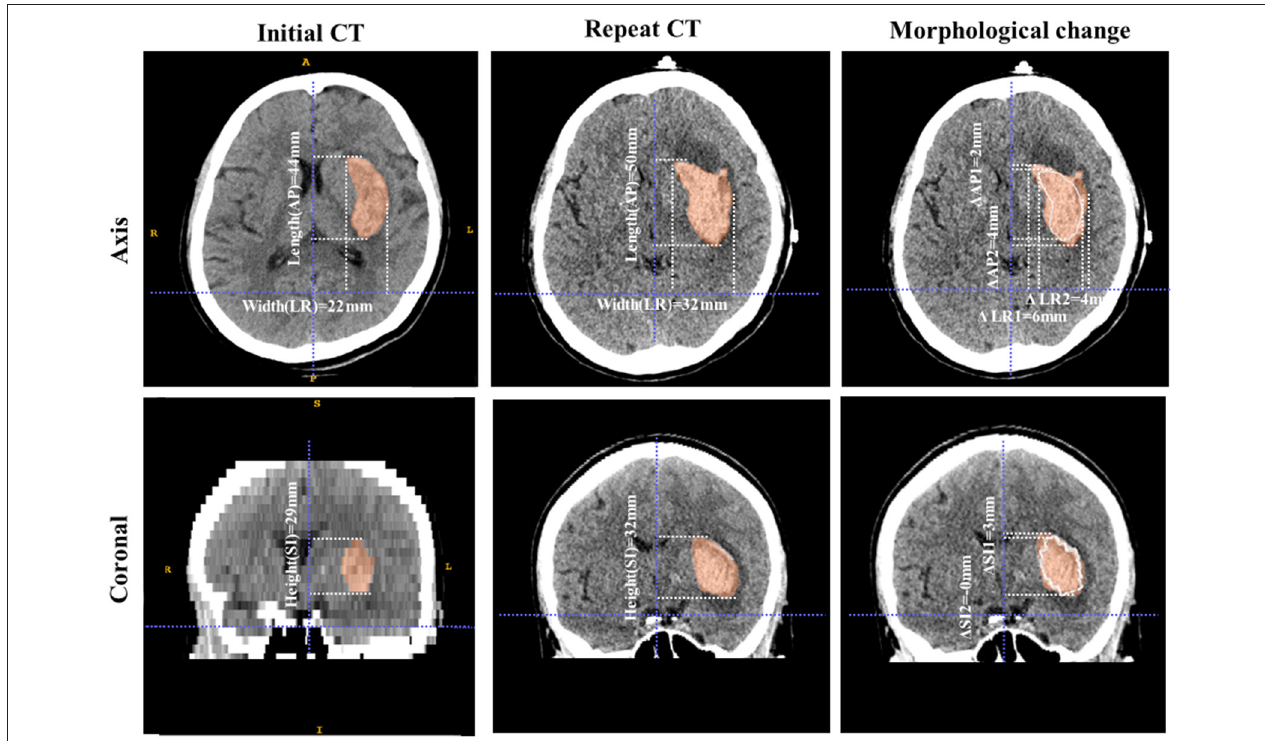
FIGURE 2 | Example of morphological change in a hematoma. These images are from a 73-year-old male patient with ICH. The volume of the hematoma was 15.6mL on initial CT and 23.5mL on repeat CT. The first column shows the shape characteristics of the initial hematoma, including its three diameters (length 44mm, width 22mm, and height 29mm). The longitudinal axis is of the AP type and the SR index is 0.628. The second column shows the shape characteristics of the hematoma on the repeat scan, including its three diameters (length 50mm, width 32mm, and height 32mm). The longitudinal axis is of the AP type and the SR index is 0.552. The third column shows the morphological change. The white line is the contour of the initial hematoma and the red area is the hematoma as of the repeat scan. The length changes of the hematoma diameters are 6mm, 10mm, and 3mm in the AP, LR, and SI directions, respectively. The direction change of the hematoma diameters is LR and the longitudinal axis type does not change (AP). The SR index decreases, which means that the hematoma becomes more irregular from initial CT to repeat CT.